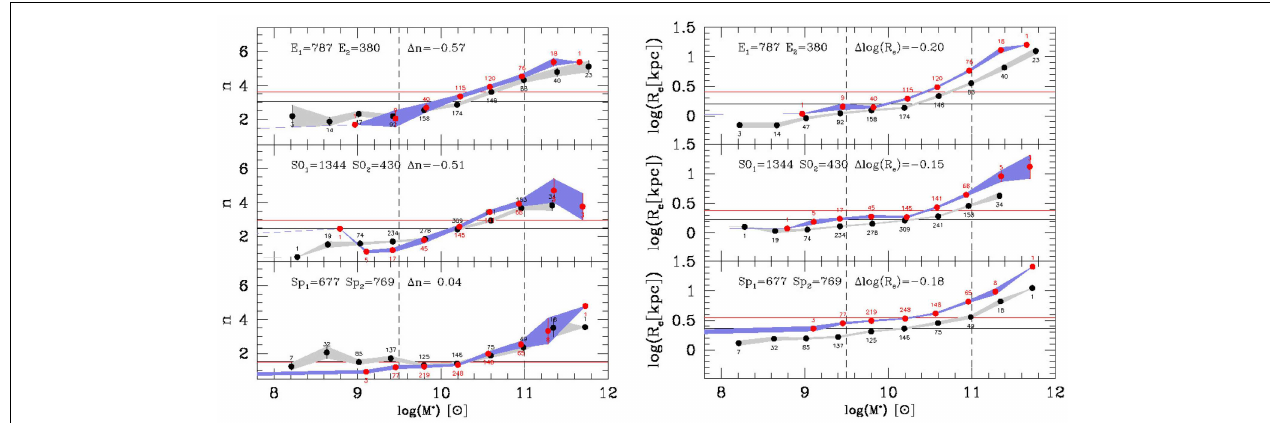
FIGURE 20 | Left: The Sérsic index of E’s (upper panel), S0’s (middle panel), and Spirals (lower panel) of galaxies in clusters (back dots and gray strips) and in the field (red dots and blue strips). Right: The effective radius in log units. Symbols as in the left panel.